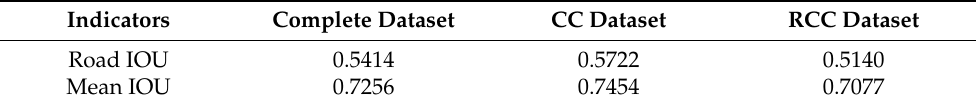
Table 3. Applying DCCA module to different datasets.